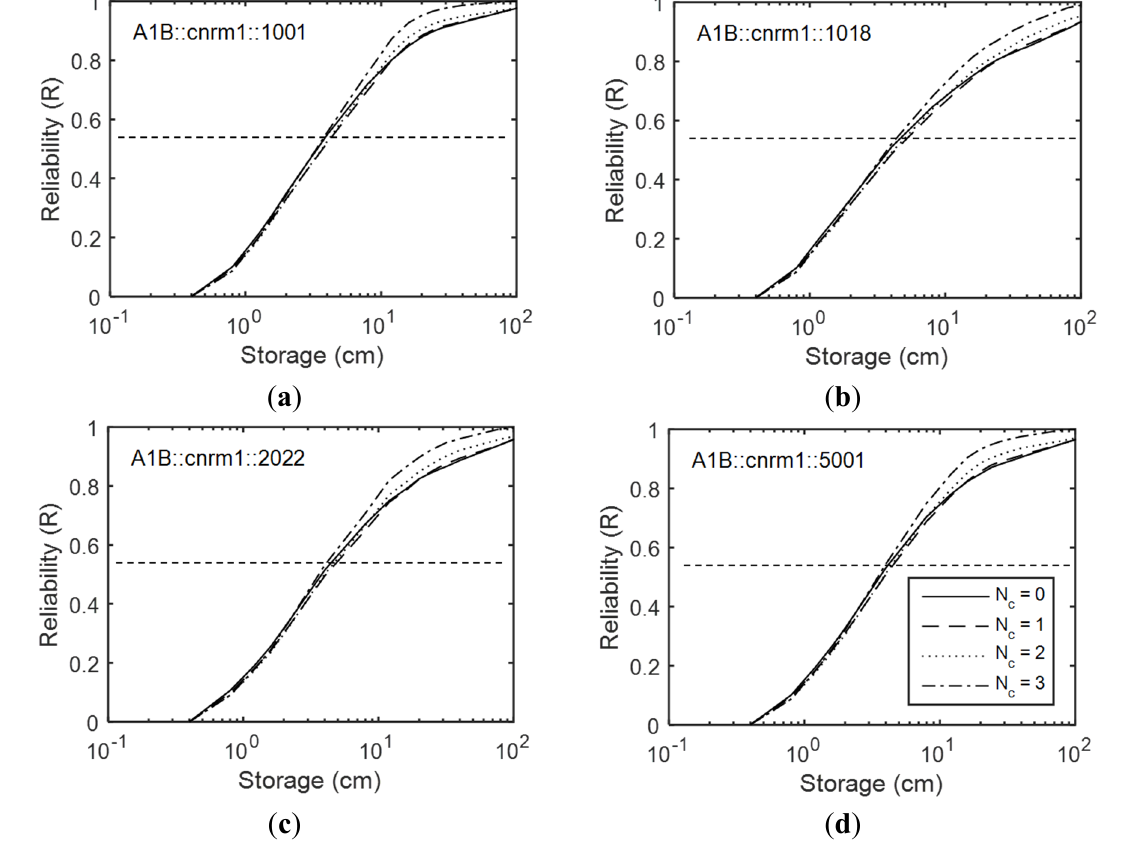
Figure 7. Reliabilities of four RBSNs under a projected climate change scenario (A1B, CNRM1) (2070–2099) for the test catchments ( a ) 1001; ( b ) 1018; ( c ) 2022 and ( d )